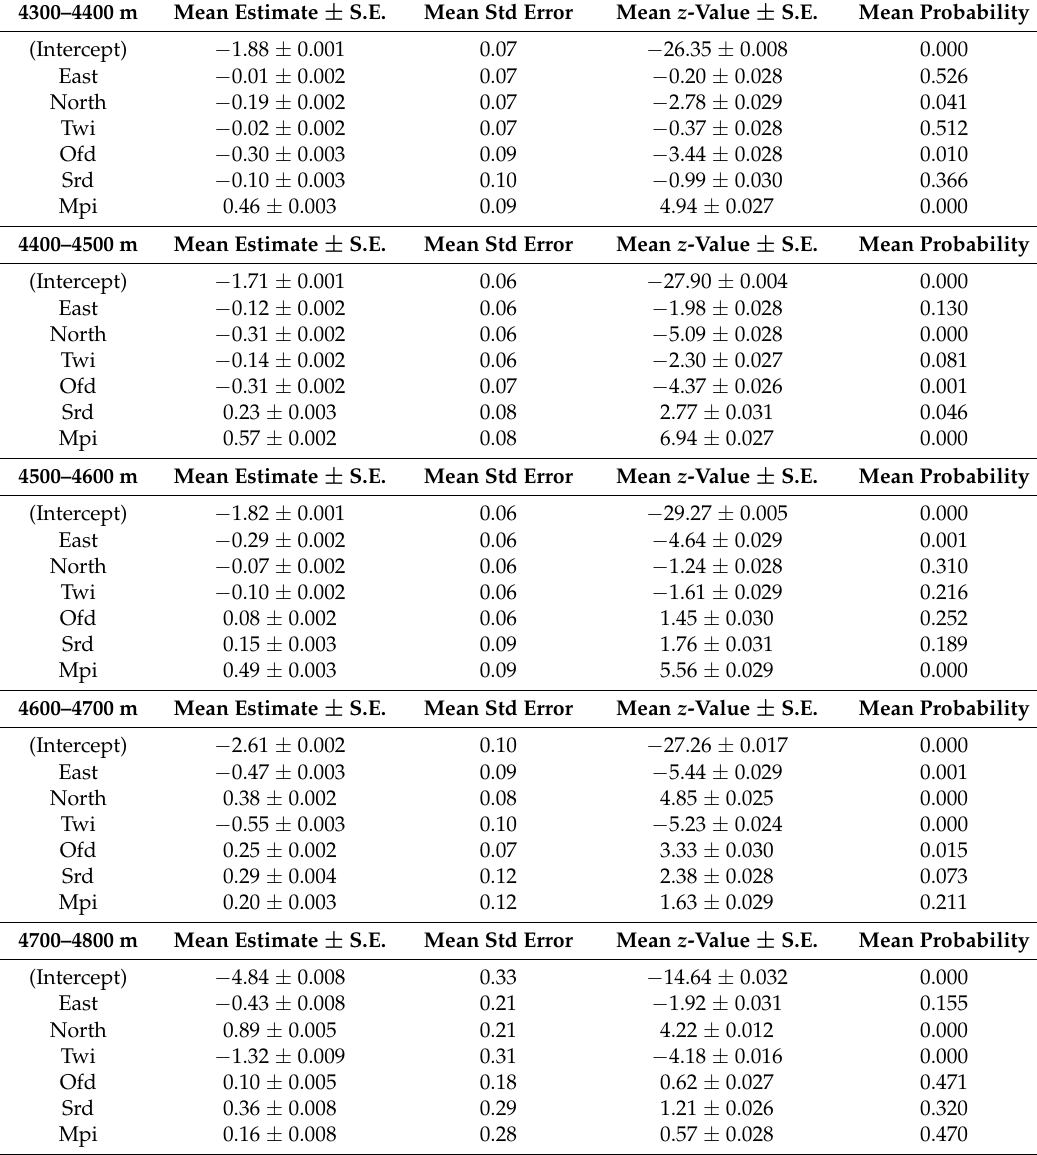
Table 3. Statistics of the logistic regression models by elevation belts divided in 100-m intervals. The analyses were carried out with a randomized subsampling of the data with 1000 repetitions, including 10% of presence and 10% of absence data in each model run. Mean estimates and their standard errors, mean standard errors, mean z -values and their standard errors, and mean p -values are reported. North = northern exposure, East = eastern exposure, Twi = topographic wetness